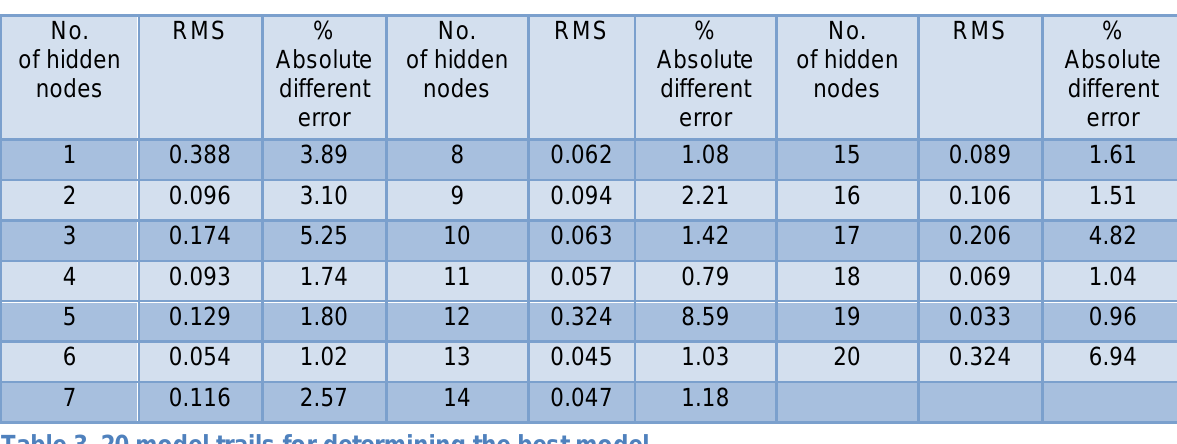
Table 3 20 model trails for determining the best model Figure 3 below present the properties of the best neural network model gained through the trial and error method at a training